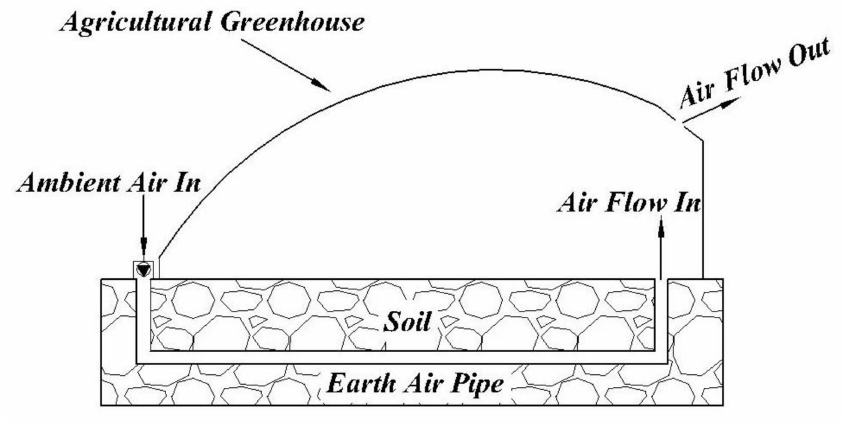
Figure 1. Schematic diagram of EAHE coupled with an agricultural